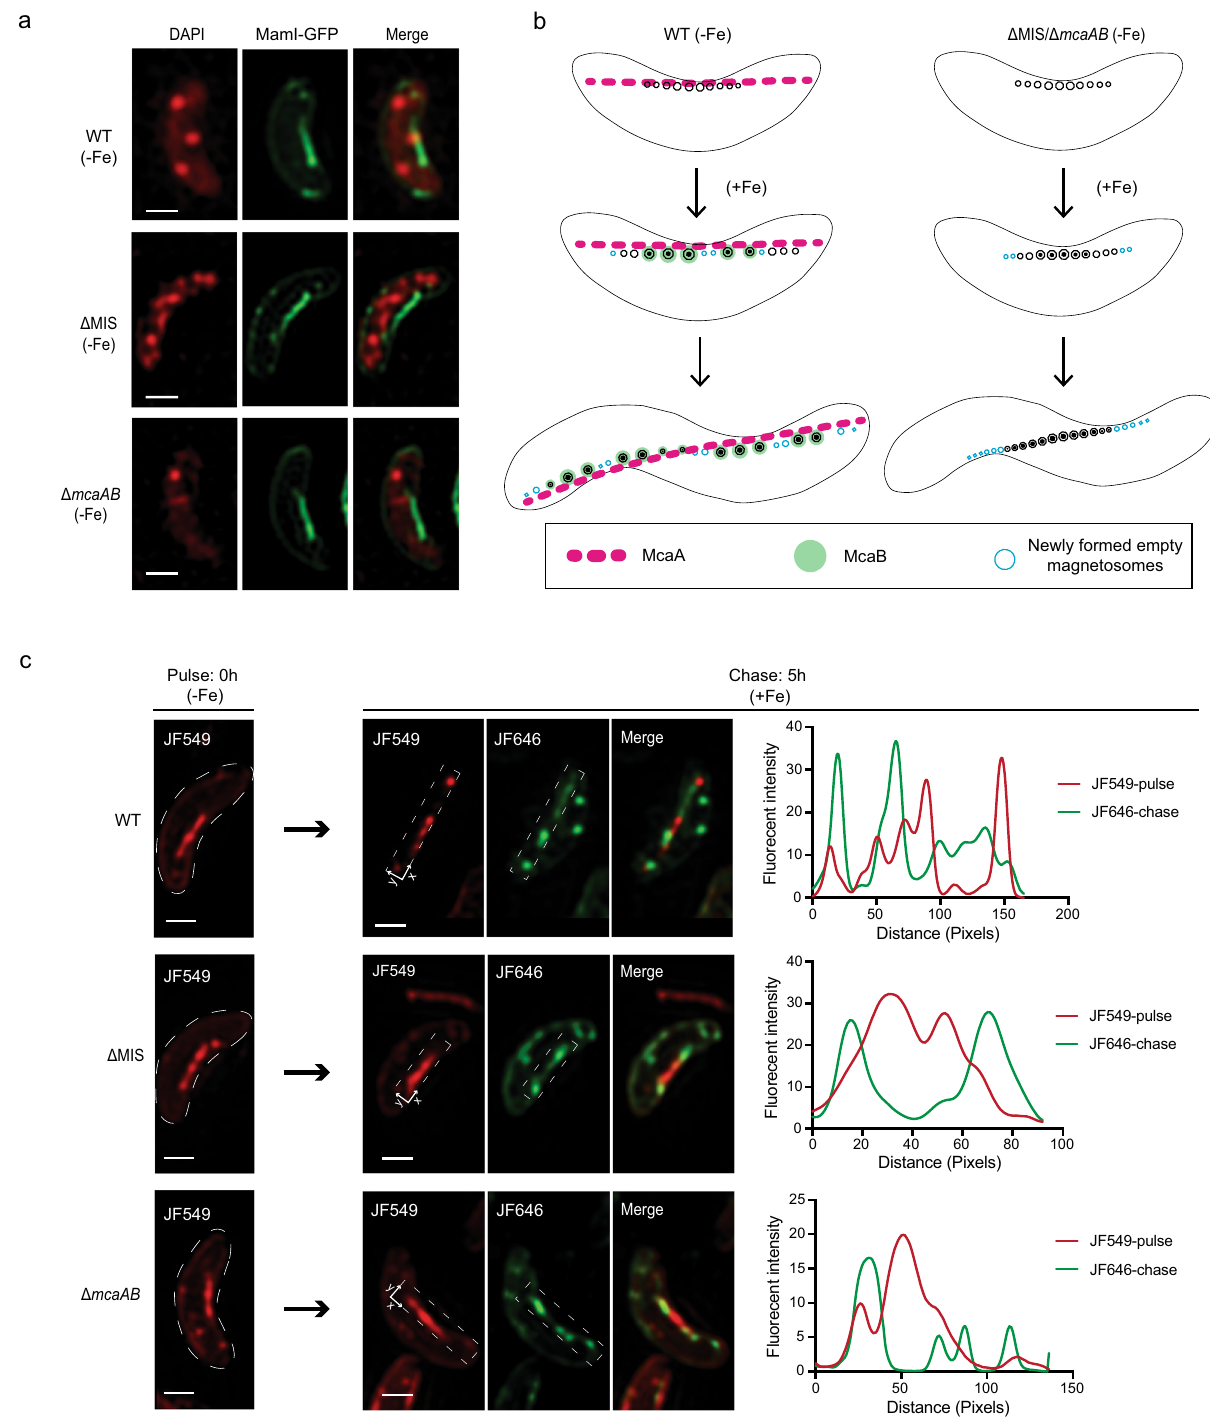
Fig. 6 | Addition of newly formed magnetosomes to the chain from iron star- vationtostandardirongrowthconditions.a Representativemaximum-intensity projection of 3D-SIM micrographs of WT, Δ MIS, and Δ mcaAB cells expressing MamI-GFP under iron starvation growth conditions. The DAPI staining is shown in false-color red,and MamI-GFP isshowningreen.MamI-GFPproteinsarelocated in the magnetosome chain and cytoplasmic membrane. b A model of how McaA and McaB coordinate to control the addition of newly formed magnetosomes in WT and Δ MIS/ Δ mcaAB cells. A continuous chain of EMs is generated in the middle of both WT and McaAB de fi cient cells underiron starvationconditions. After the iron is added to the medium, magnetic crystals are mineralized in the existing EMs 33,59 . OnceEMsbecomeCMs,theMcaBisrecruitedtoCMsandhelpslocatingCMstothe